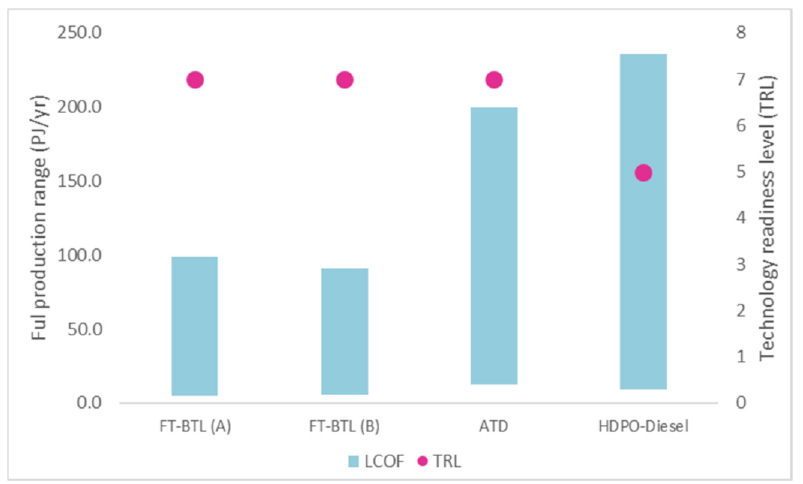
Figure 21. Fuel production and technology readiness for each biobunker fuel pathway. Note: As SVO and HVO fuel production levels were far below other technologies, they are not represented. However, both are mature technologies.